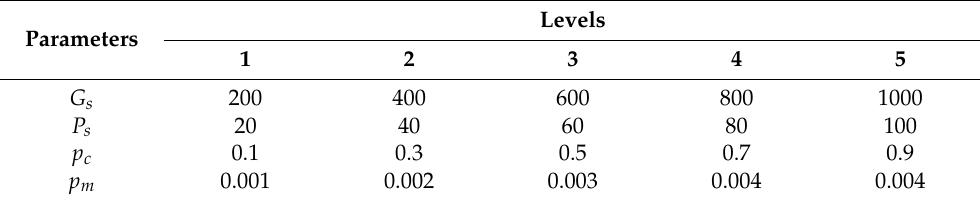
Table 2. The value of each level of GA parameters.